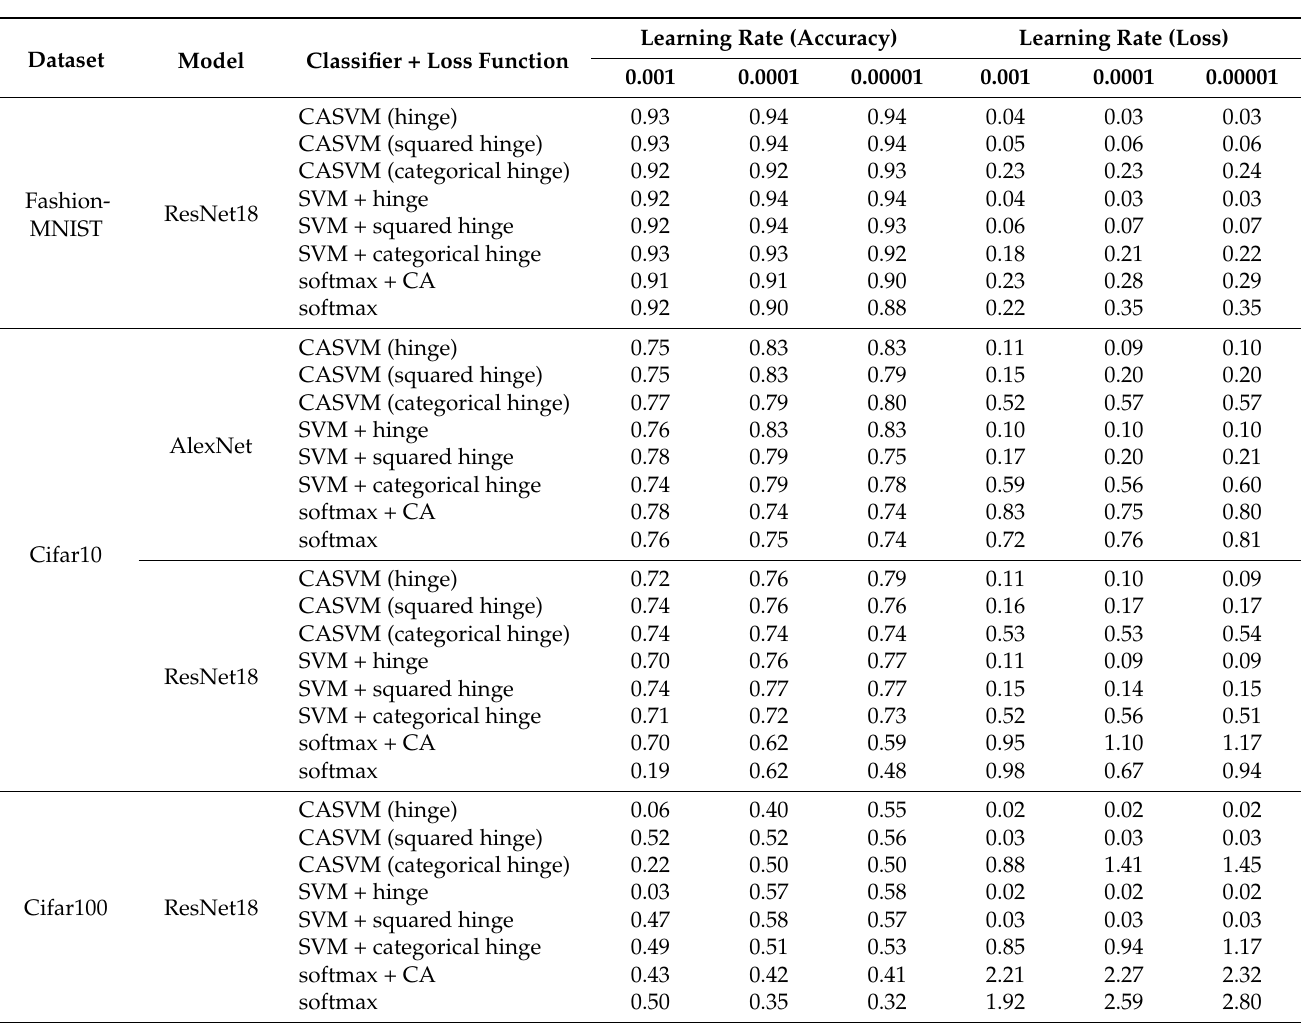
Table 4. Image classification accuracy and loss values for small